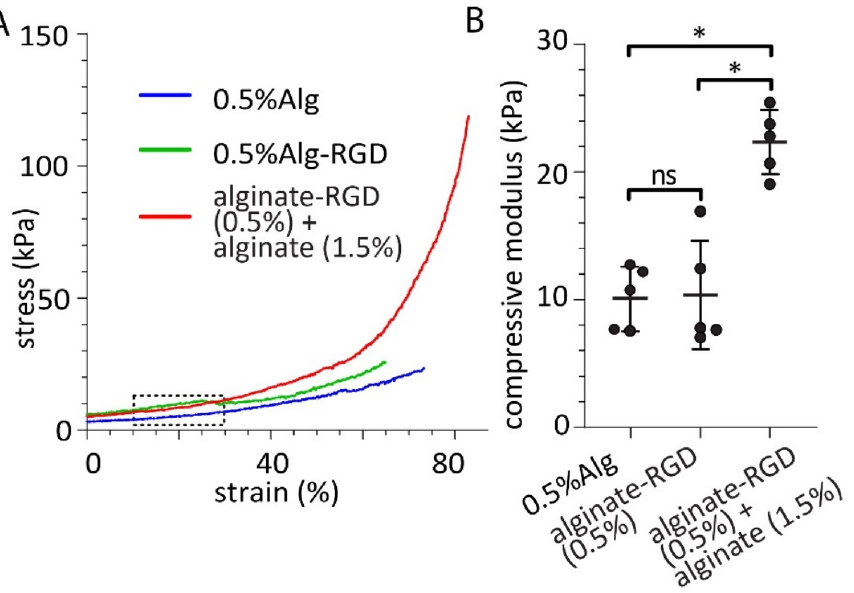
Figure 6. Mechanical properties of alginate hydrogels. ( A ) Stress–strain curves of 0.5% alginates without RGD and with RGD, and 0.5% alginate with RGD plus 1.5% alginate. ( B ) The compressive modulus of the different alginate hydrogels measured from the linear region (10–30% strain—dashed line in ( A )). Statistical analysis, one-way ANOVA with Turkey post hoc test. * p < 0.05, ns = non-significant.